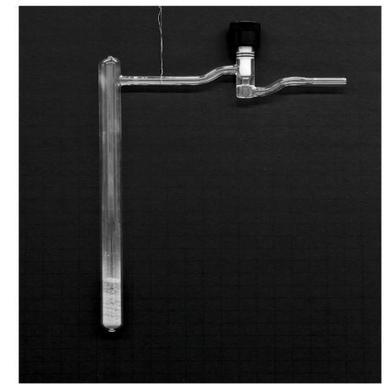
Sample reactor: quartz tube, containing 10 g of lunar regolith simulant material, with a shut-off valve. The quartz tube is inserted in a vertical furnace (1), shown in.